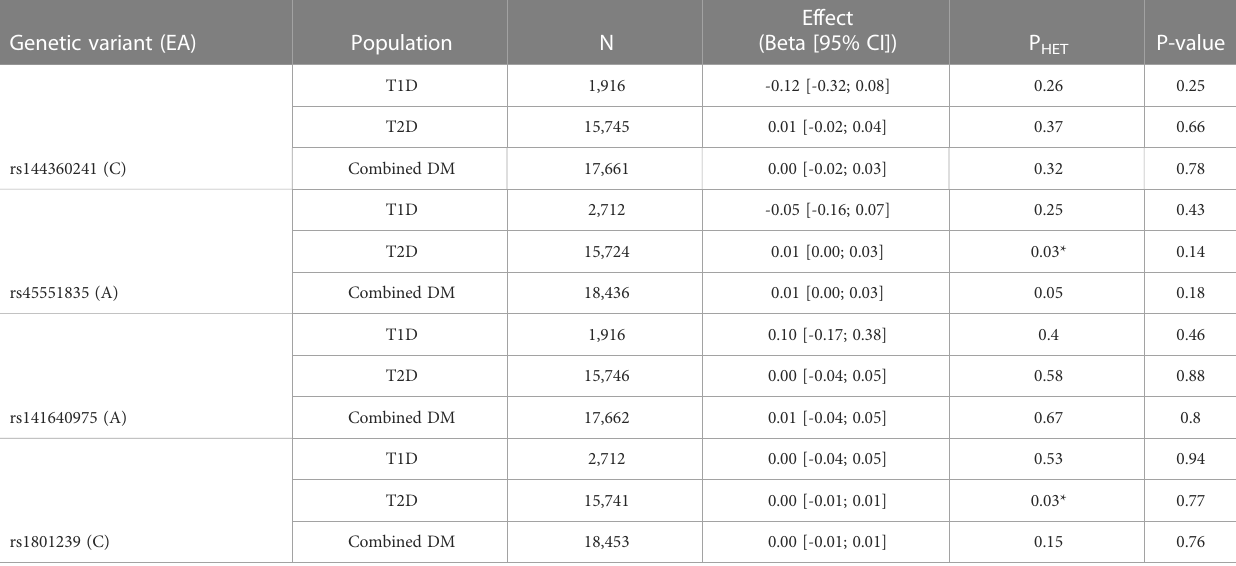
TABLE 3 meta-analysis of SNV-eGFR creatinine summary data in diabetes mellitus and its subtypes (model 2).